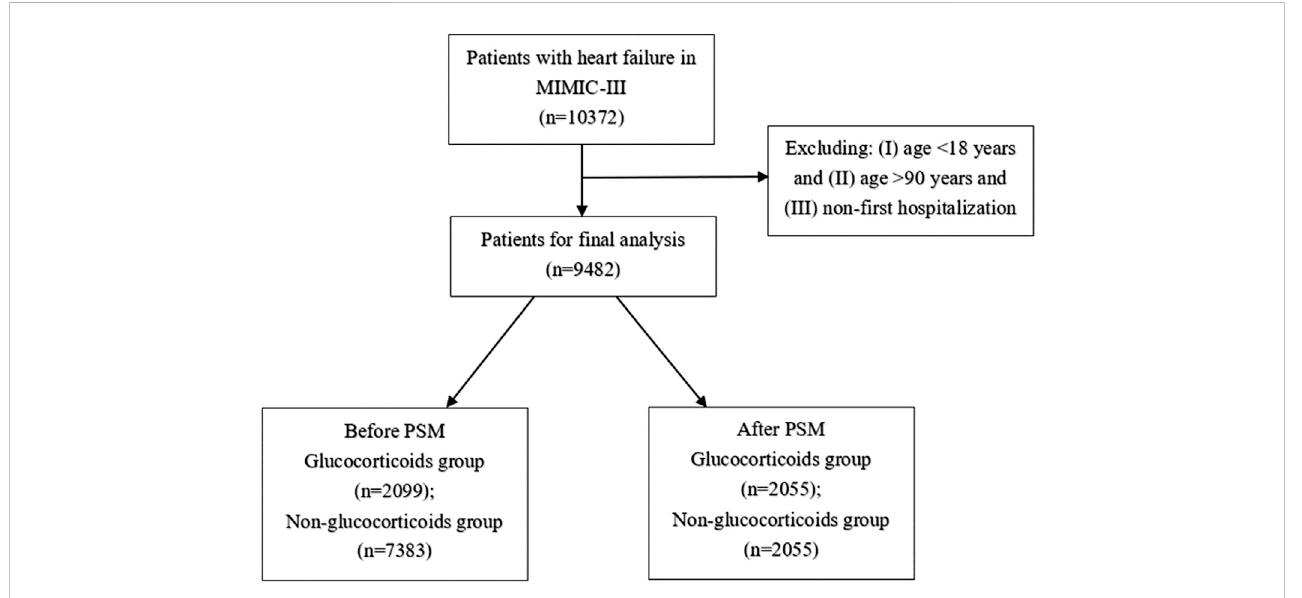
FIGURE 1 Selection of study population from MIMIC- Ⅲ